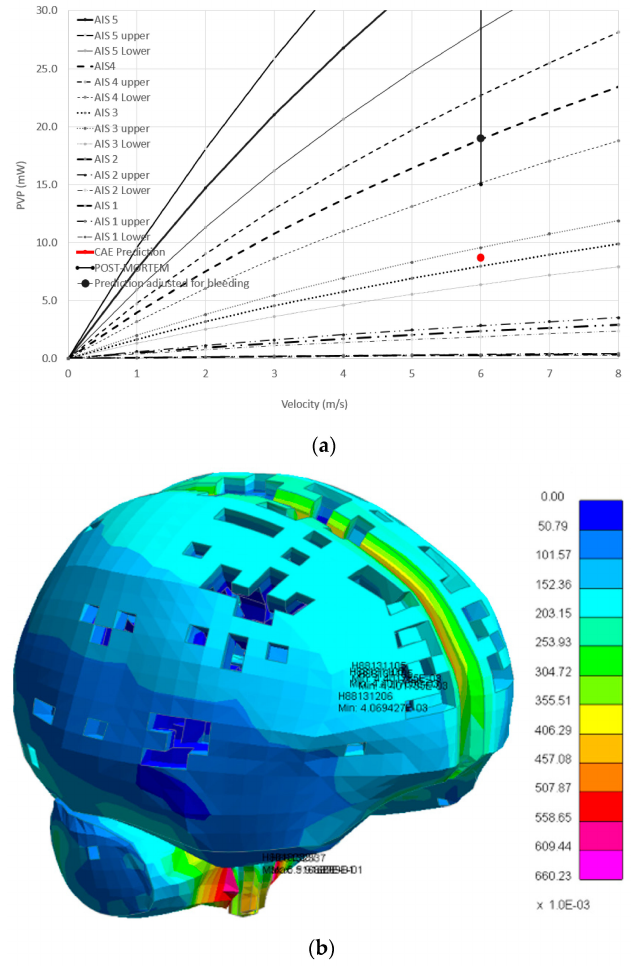
Figure10. OccipitalGreyMatterOTMModel. ( a )Occipitalgreymattertraumaprediction, ( b )Maximum Principal strain (grey